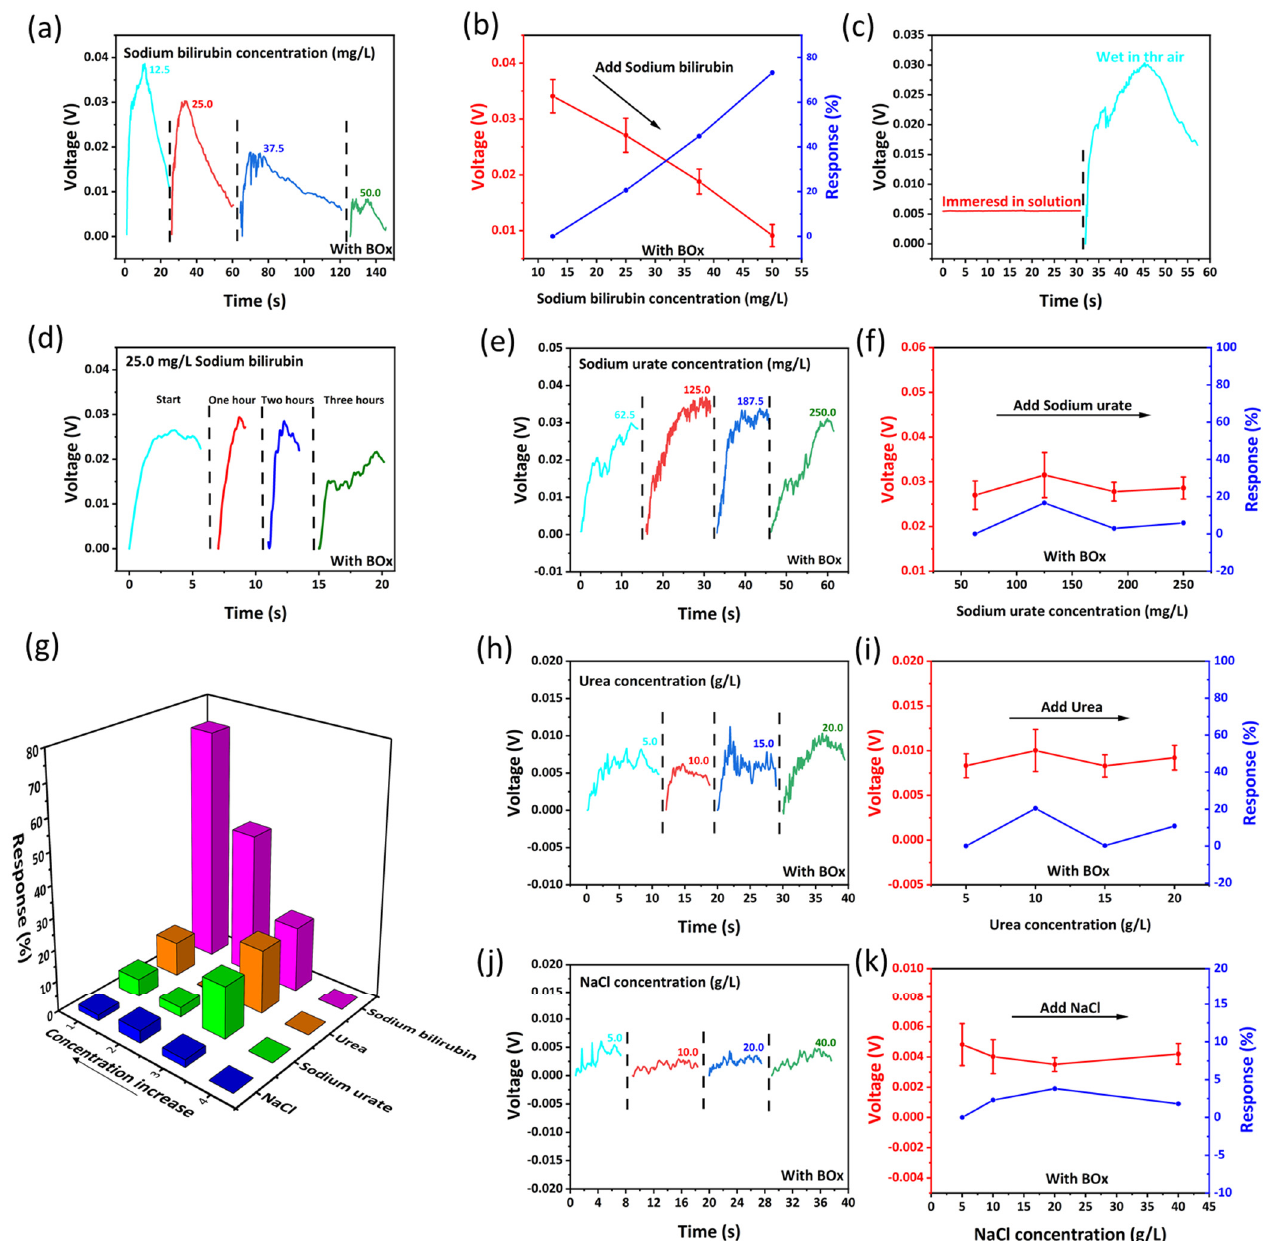
Figure 4. ( a ) The sodium bilirubin biosensing performance of the self-powered wearable biosensor. ( b ) The response of the device. ( c ) Control experiment of the device eliminate primary cell effect. ( d ) The repeatability of the device. ( e – k ) The response of the device against sodium urate, urea and NaCl.